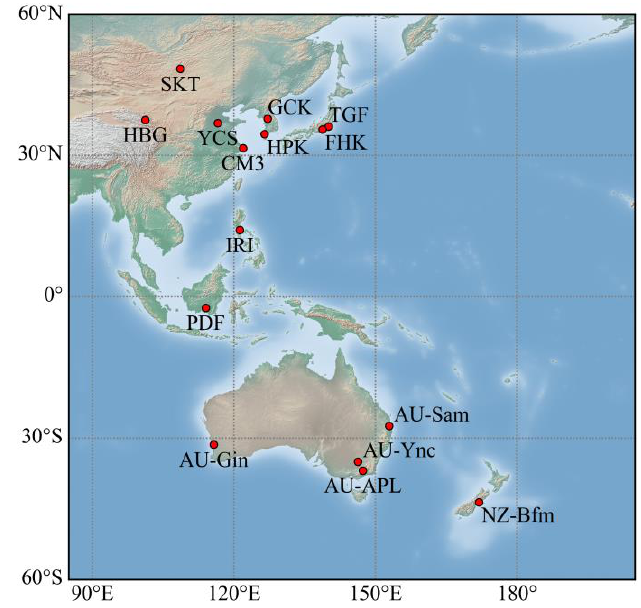
Figure 1. Spatial distribution of the selected site. Detailed information on site abbreviations is shown in Table 1. The geographic range of this figure is based on the spatial coverage of Himawari-8 AHI dataset provided by the Center for Environmental Remote Sensing (CEReS), Chiba University. dataset provided by the Center for Environmental Remote Sensing (CEReS), Chiba